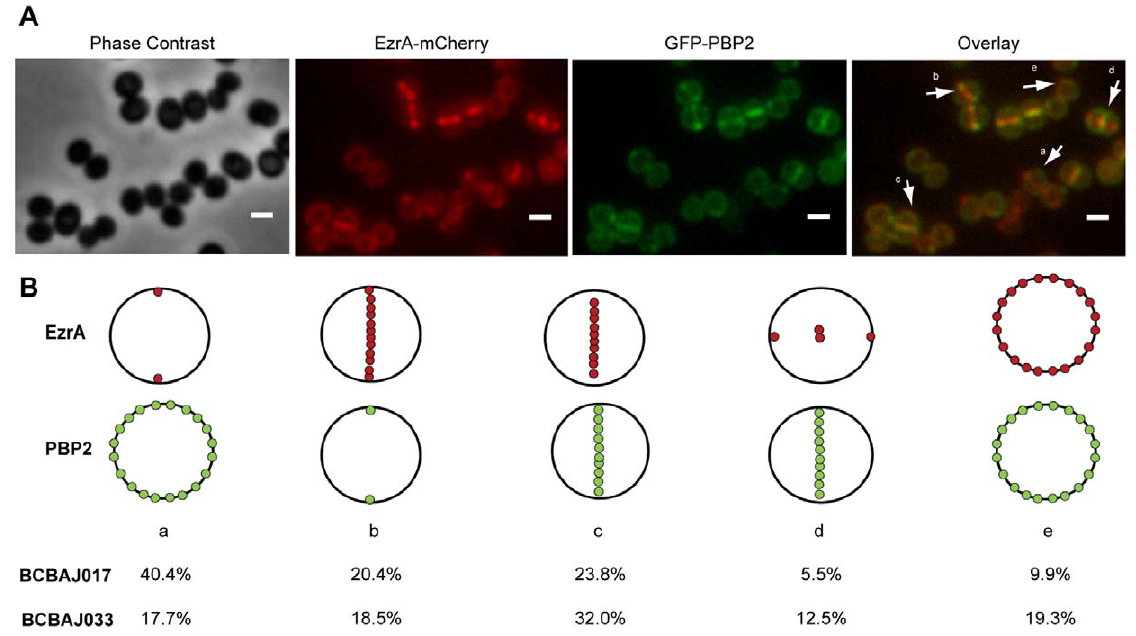
Figure 8. EzrA-mCherry and GFP-PBP2 do not colocalize during the entire cell cycle. (A) From left to right: Phase contrast, EzrA-mCherry fluorescence, GFP-PBP2 fluorescence and overlay of EzrA-mCherry and GFP-PBP2 fluorescence images of strain BCBAJ017 expressing, simultaneously, EzrA-mCherry and GFP-PBP2 in the COL background. Arrows show cells representative for each class (see below). (B) Localization of EzrA-mCherry and GFP-PBP2 was analyzed in 1420 cells for strain BCBAJ017 (COL background) and 802 cells for strain BCBAJ033 (NCTC8325-4 background) which were assigned to the following classes: (a) EzrA-mCherry localized in two spots, corresponding to the beginning of septa formation while GFP-PBP2 is not yet present at mid cell; (b) EzrA-mCherry is present across the entire septum while GFP-PBP2 is present as two dots, corresponding to a ring around the septum; (c) both proteins co-localize at the septum; (d) EzrA-mCherry is starting to localize to the next division site and GFP-PBP2 is still present in the previous septum; (e) both proteins are dispersed at the cell membrane. Red dots represent EzrA-mCherry and green dots GFP-PBP2. Frequency of cells in each class was calculated for BCBAJ017 (COL ezrA::ezrA-mCherry, pbp2::gfp-pbp2 ) and BCBAJ033 (NCTC8325-4 ezrA::ezrA-mCherry, pbp2::gfp- pbp2